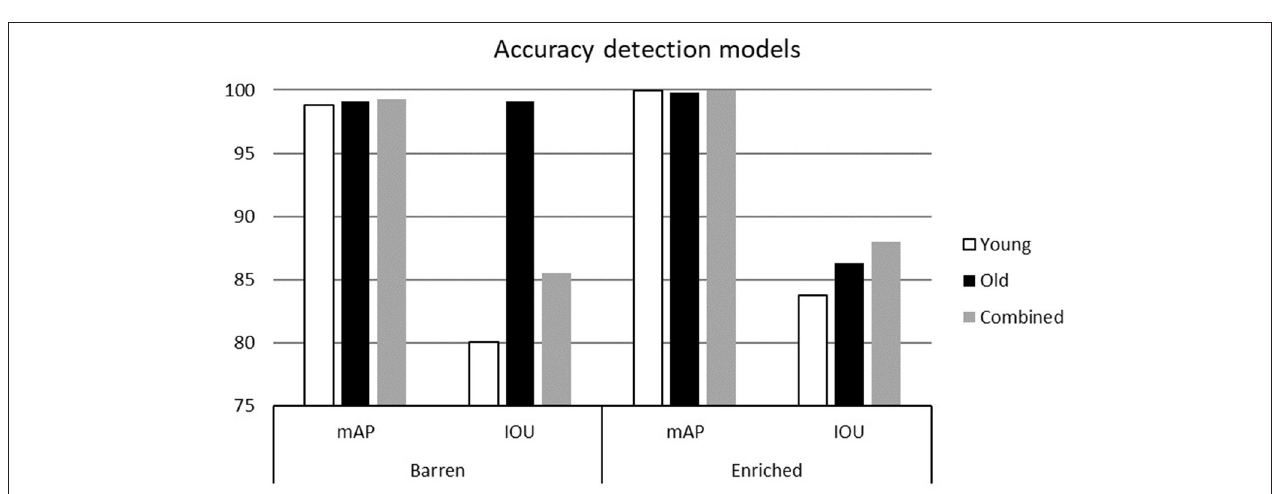
FIGURE 4 | Mean Average Precision (mAP) and Intersection Over Union (IOU) for the barren and enriched environment using the “young,” “old,” and “combined” detection